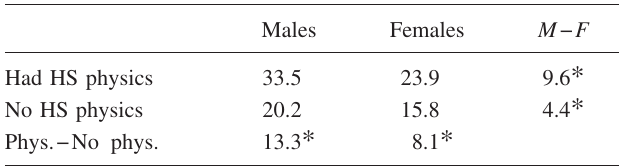
TABLE VI. Average FMCE pretest scores for males and fe- males who did and did not take high school physics. The asterisk (cid:1) * (cid:2) indicates that the difference is statistically significant at p (cid:3)